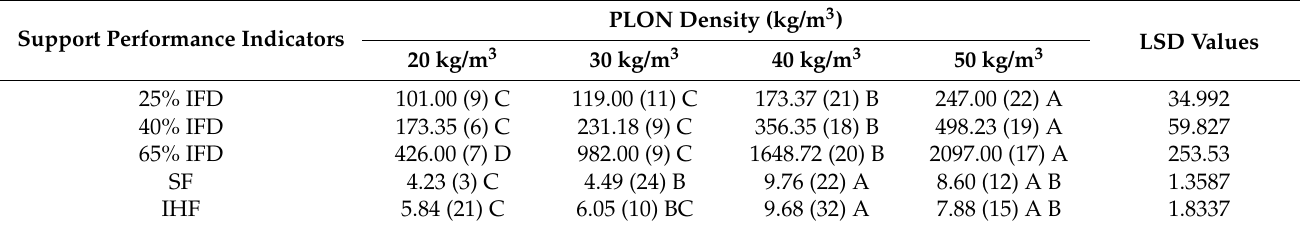
Table 4. Mean Support performance indicators Values of the four PLON Densities Evaluated in this Study. Support Performance